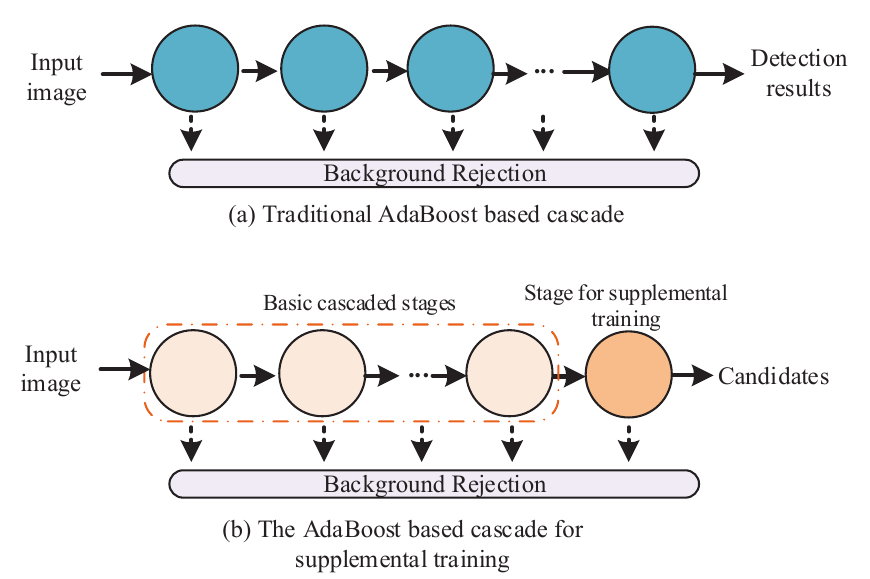
Figure 2. The structure difference between the traditional cascade and our AdaBoost-based cascade for supplemental